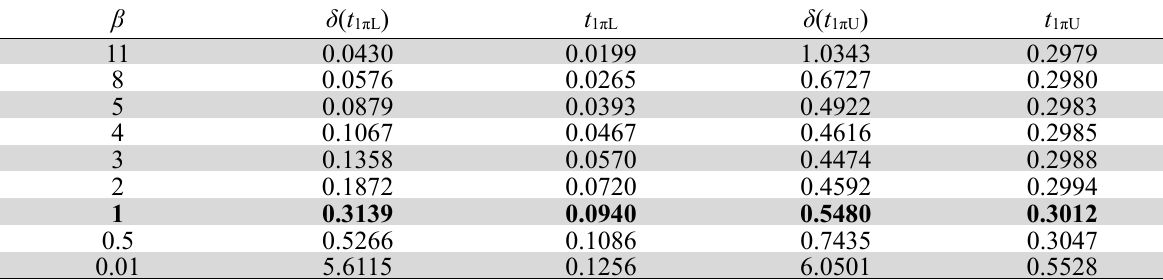
Verification of convexity of E [ TCU ( t 1 π )] against different β